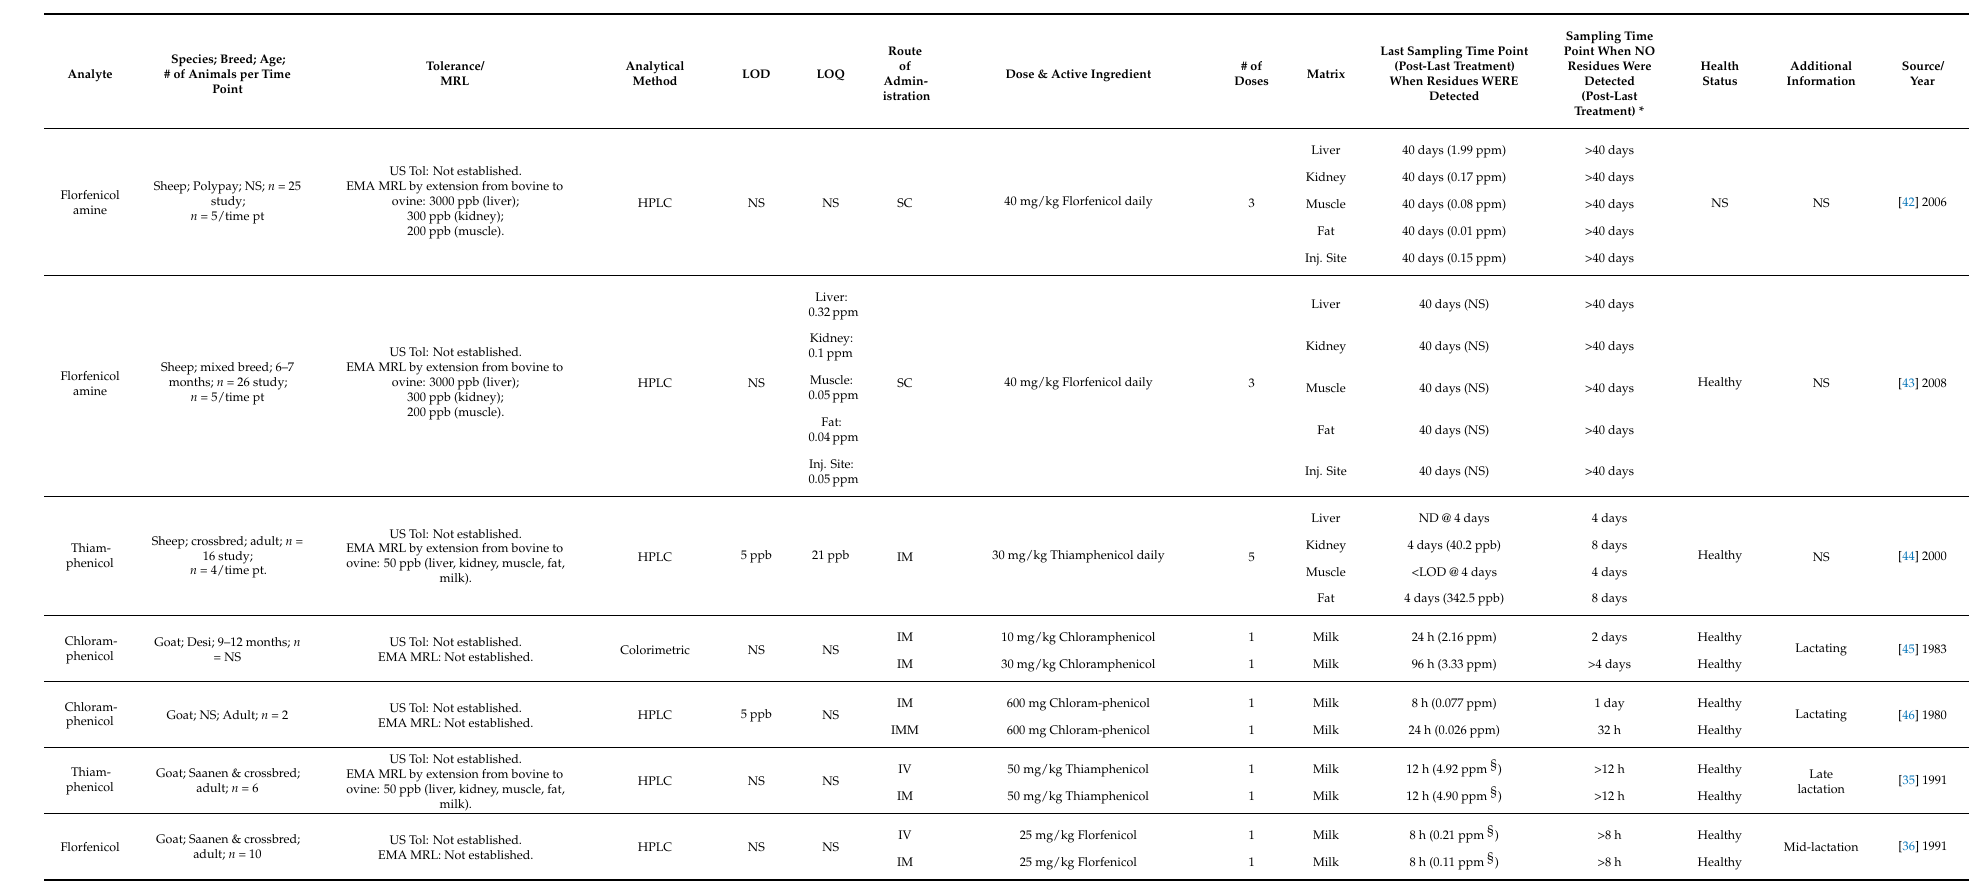
Florfenicol Goat;Saanen&crossbred; adult; n